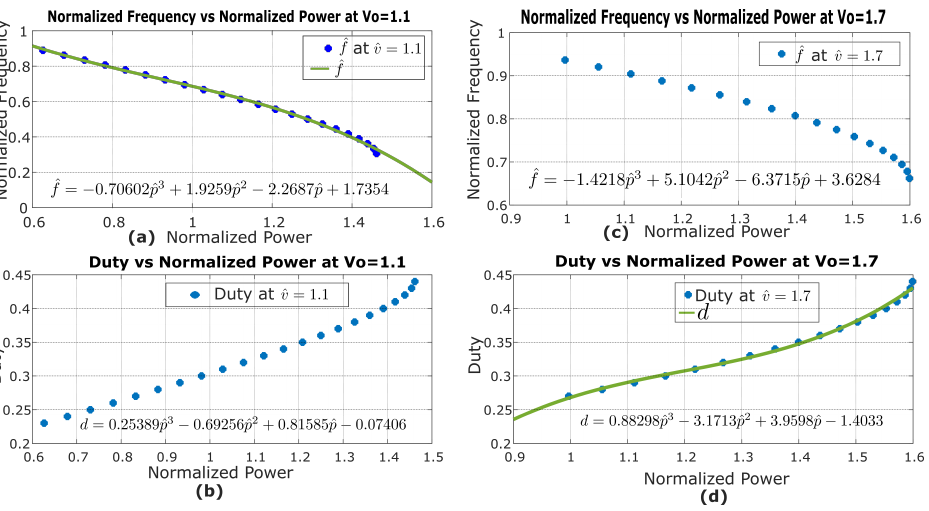
Figure 7. Data-fitting application on frequency and duty in presence of ˆ v = 1.1 and ˆ v = 1.7. ( a , b ) show data fitting for frequency and duty at ˆ v = 1.1, while ( c , d ) show data fitting for frequency and duty at ˆ v =